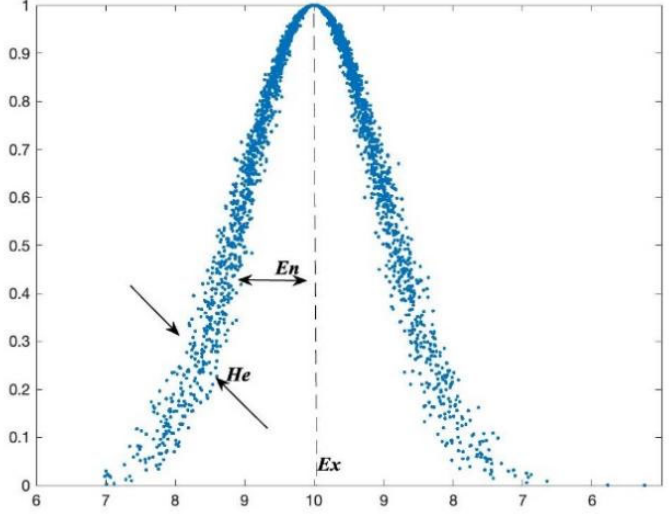
Figure 1. Cloud model of shooting results.